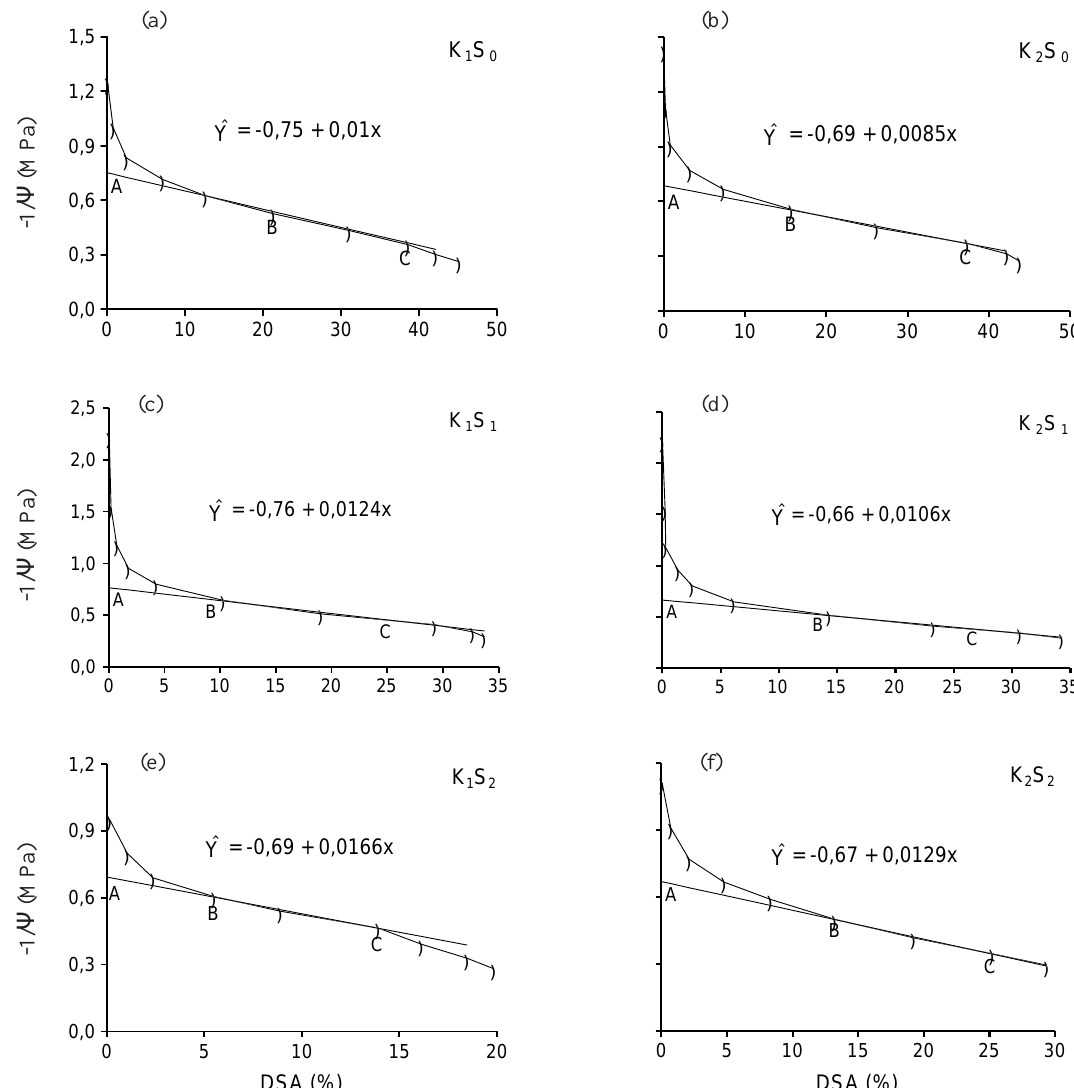
Figura 1. Curvas pressão-volume para o inverso do potencial de água em função do déficit de saturação por água (DSA) para calcular o potencial osmótico (ponto A) na folha de plantas de milho submetidas a duas doses de potássio (K) e três níveis de estresse hídrico (S), 76 a 78 dias após a